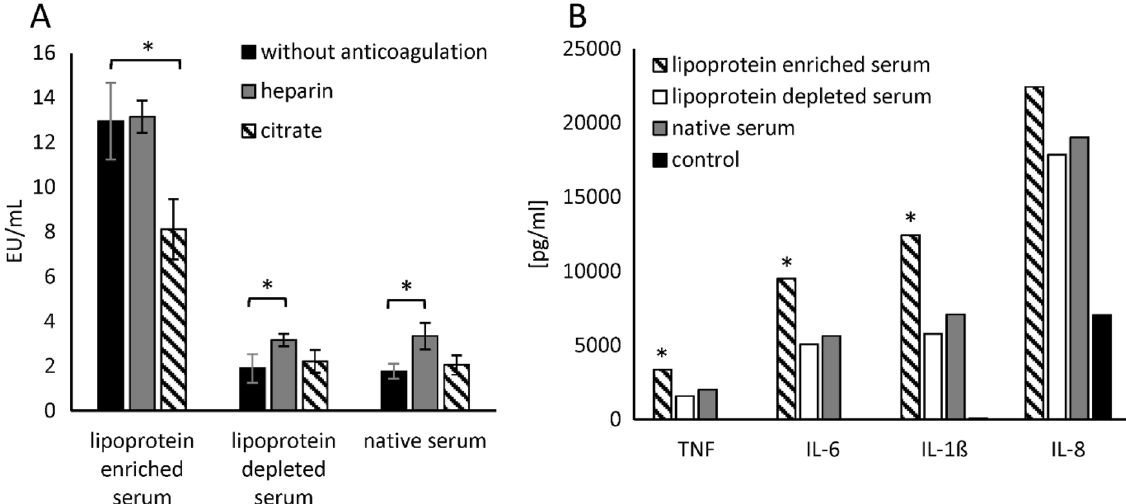
Figure 11. ( A ) Endotoxin recovery between native serum, lipoprotein-depleted and lipoprotein-enriched serum in dependence of anticoagulation. Native serum, lipoprotein-enriched and -depleted serum was spiked with heparin (10 IU/mL), citrate (9 mM) or ringer solution for volume compensation in samples without anticoagulation. Endotoxin recovery of 5 ng/mL LPS ( E. coli ) was determined in the different serum samples. Mean ± standard deviation of three independent experiments are shown. The bars marked with * show a significantly (p < 0.05) difference in endotoxin activity compared to serum without anticoagulants. ( B ) Monocyte stimulation experiment with LPS, which was incubated in different plasma fractions. LPS was incubated in native serum, lipoprotein-enriched serum and lipoprotein-depleted serum for 24 h. Freshly collected serum blood was spiked (1 ng/mL) with these differently pre-incubated endotoxins. After 4 h incubation at 37 °C the serum levels of TNF-α, IL-1β, IL-6 and IL-8 were determined to test the biological activity of the different pre-incubated